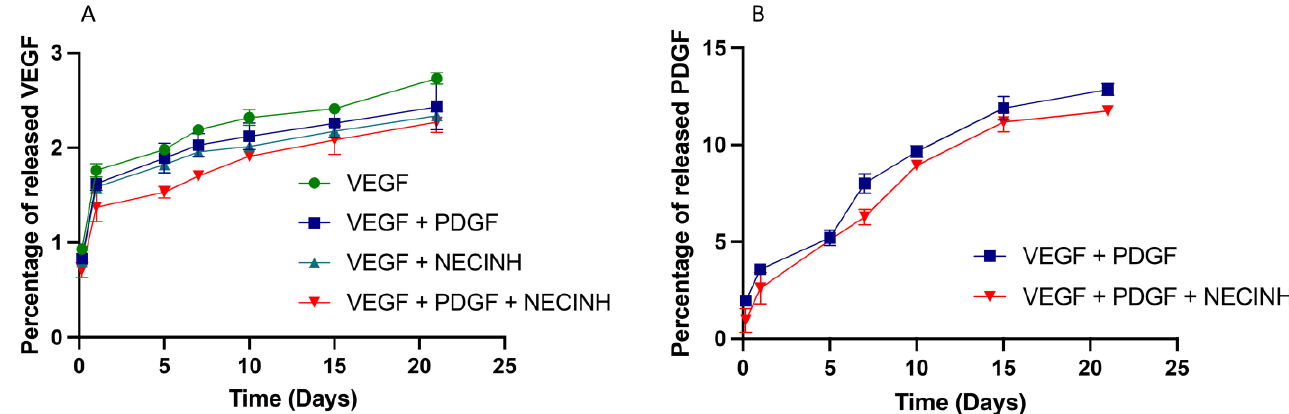
Figure 1. In vitro release of vascular growth factors from NPs incorporated alone or in combination with other NPs, in an alginate hydrogel. ( A ) VEGF-loaded PLGA:PLGA-PEG NPS and ( B ) PDGF-loaded PLGA:PLGA-PEG NPs were embedded in a 1% alginate matrix and VEGF and PDGF were quantified in the release buffer (40 mM CaCl 2 PBS) at 34 °C for 21 days ( n = 4).